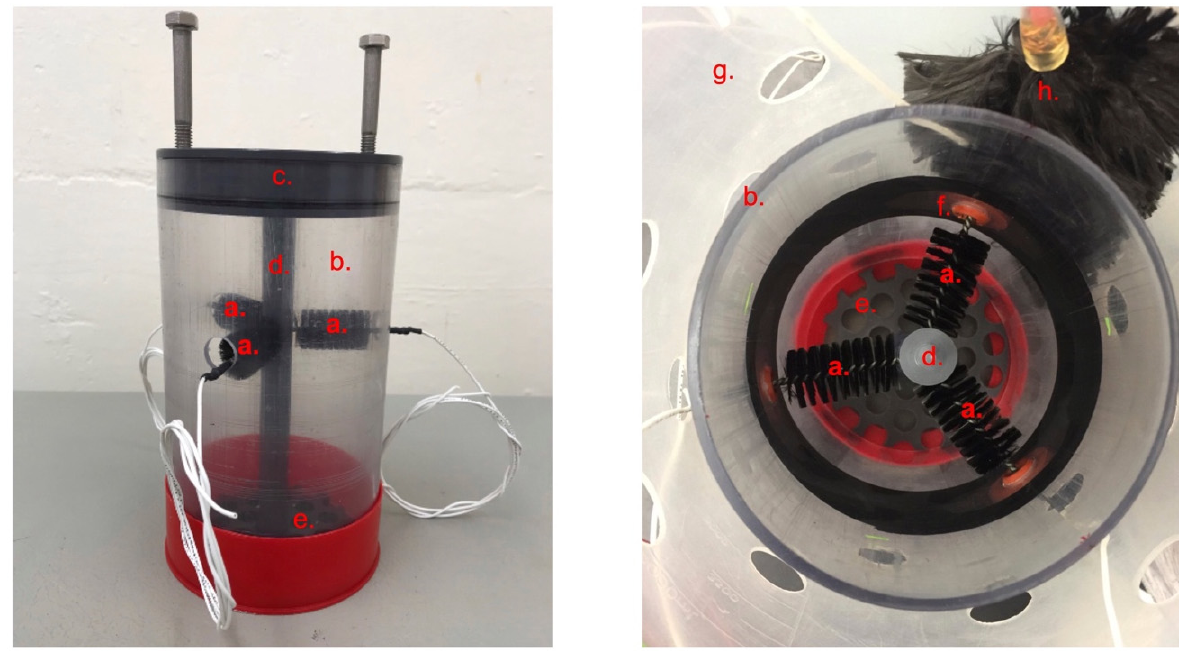
Figure 1. Photos of the bioelectrochemical reactor parts: ( a ) carbon brush electrodes serving as anodes, ( b ) polycarbonate core tube, ( c ) lid, ( d ) center rod, ( e ) perforated bottom partition, ( f ) septum, ( g ) perforated plastic beaker, and ( h ) cathode.